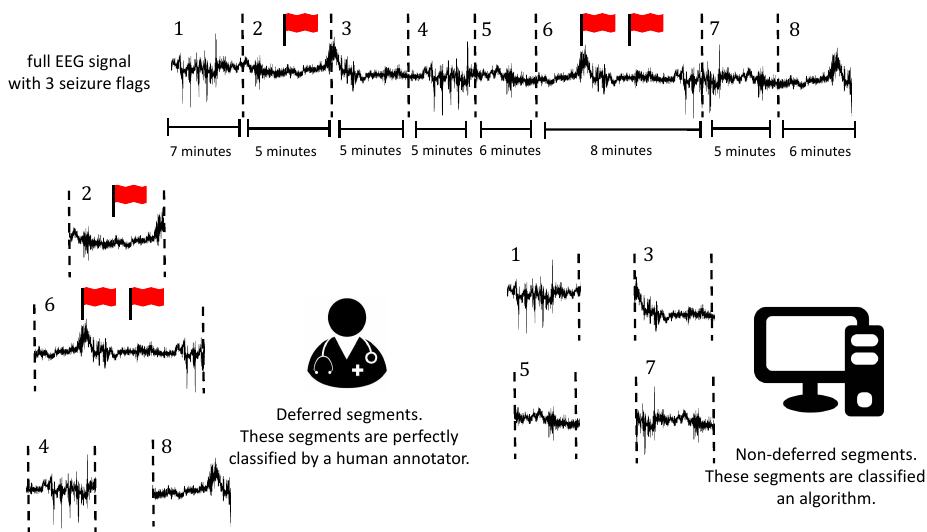
Figure 3. Visualisation of the deferral scheme. EEG segments are deferred to a human annotator or they are classified by an algorithm. The human annotator is assumed to annotate perfectly. Segments that contain seizure flags are always deferred. The minimum length of a segment is 5 min, but they can be longer (e.g., if they contain several seizure flags or are on a boundary). For the example in this figure, segments 2 and 6 are automatically deferred because they contain seizure flags. Segments 4 and 8 are deferred because the classifier is the least confident regarding its classification for these segments. Segments 1, 3, 5 and 7 are classified by the